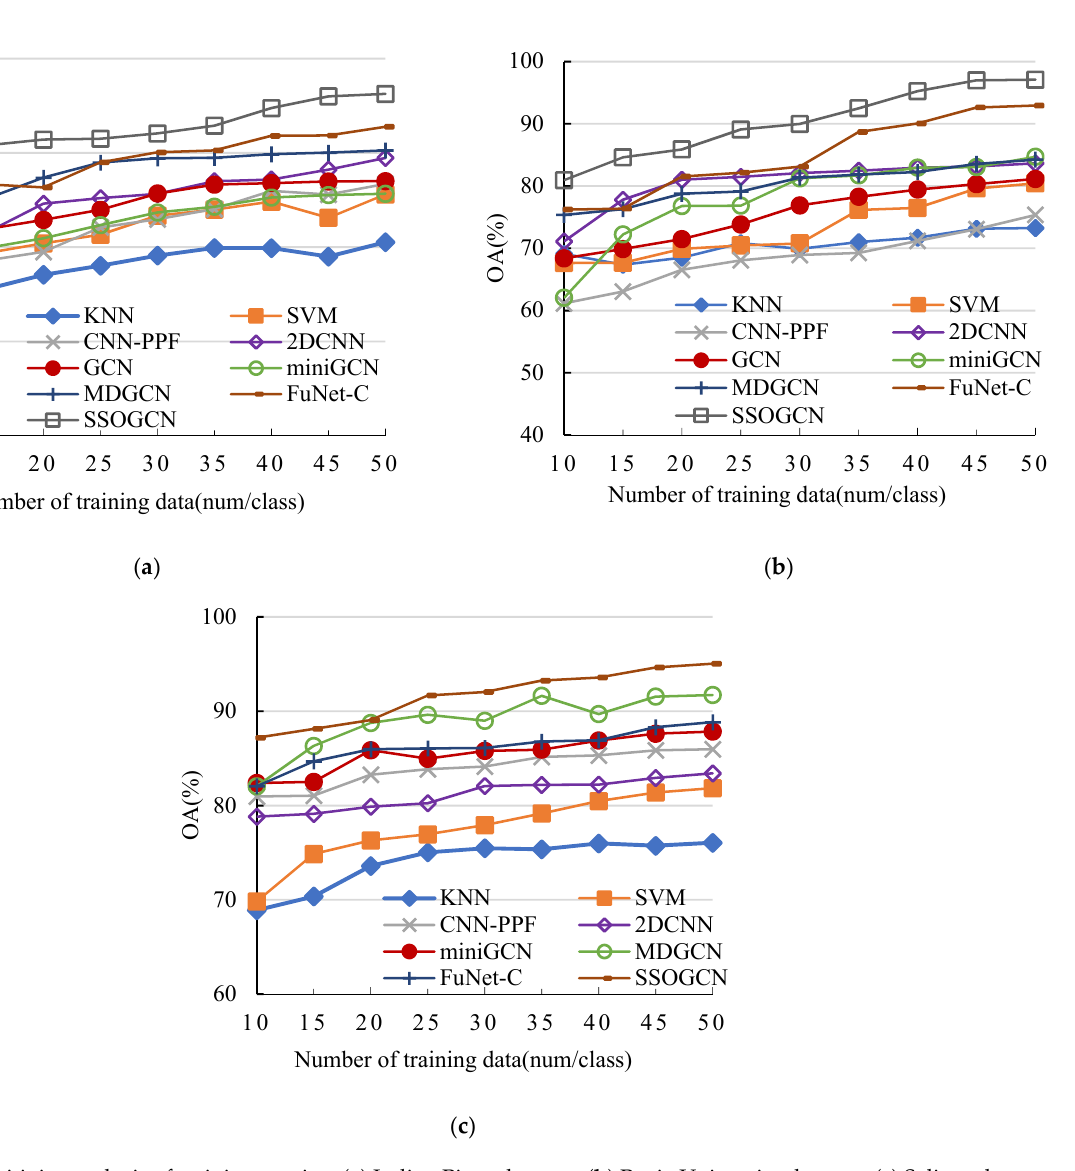
Figure 12. Sensitivity analysis of training set size. ( a ) Indian Pines data set. ( b ) Pavia University data set. ( c ) Salinas data set. Table 10. Run time comparison and parameter number comparison of depth model in the Pavia University data